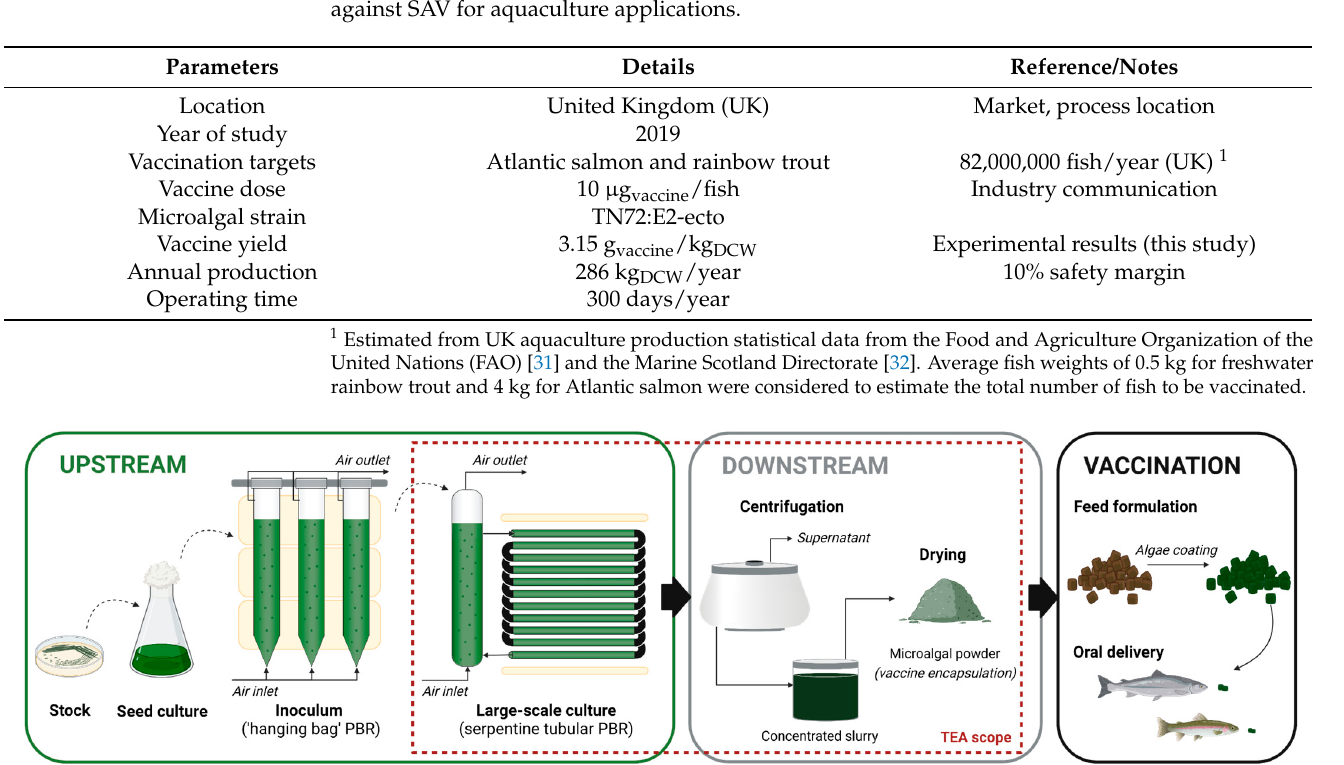
Figure 2. Process steps for the large-scale production of a microalgae-based edible vaccine against SAV, from the preparation of the inoculum for large-scale cultivation in photobioreactors (PBR) to the oral delivery of the vaccine. The scope of the present techno-economic analysis (TEA) is delimited by the red dotted-line rectangle. (Figure created with BioRender.com.)